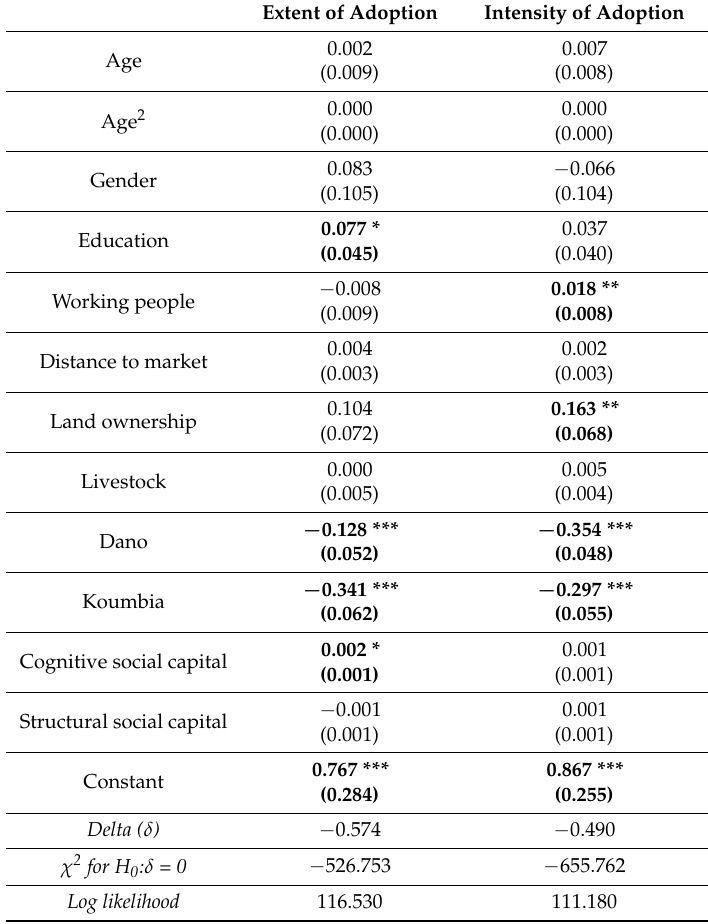
Table 4. Results of the generalized Poisson regression